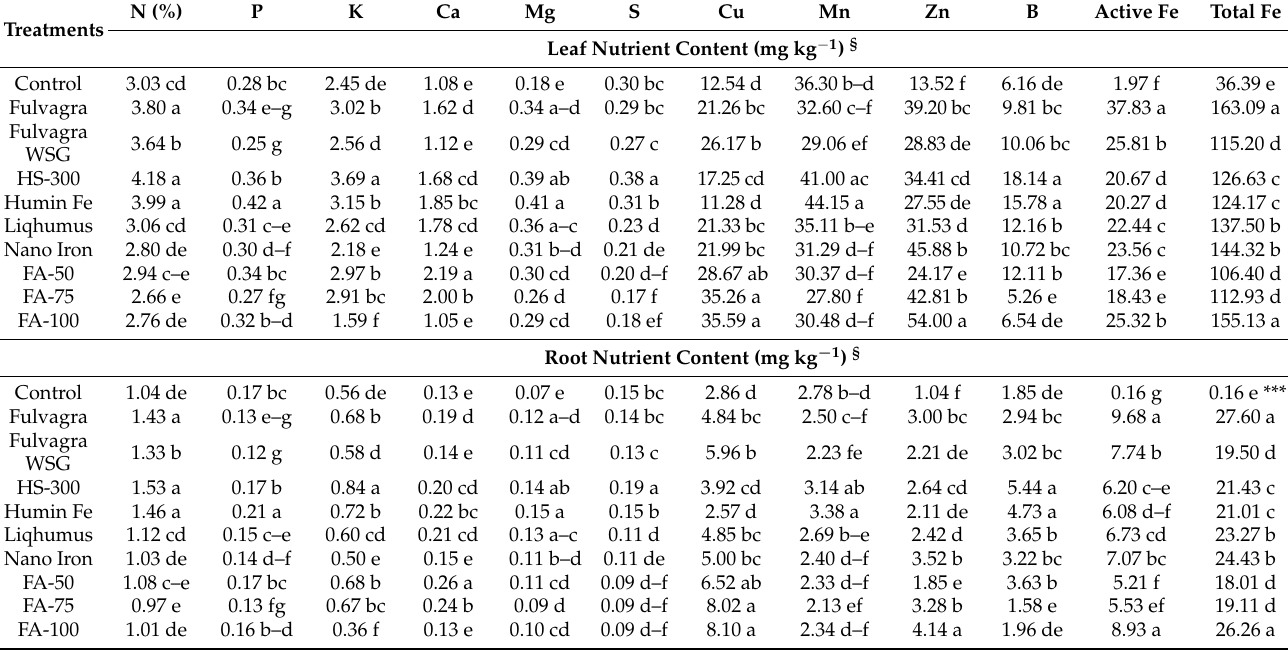
Table 3. Effects of different treatments on leaf and root macro- and micro-nutrient